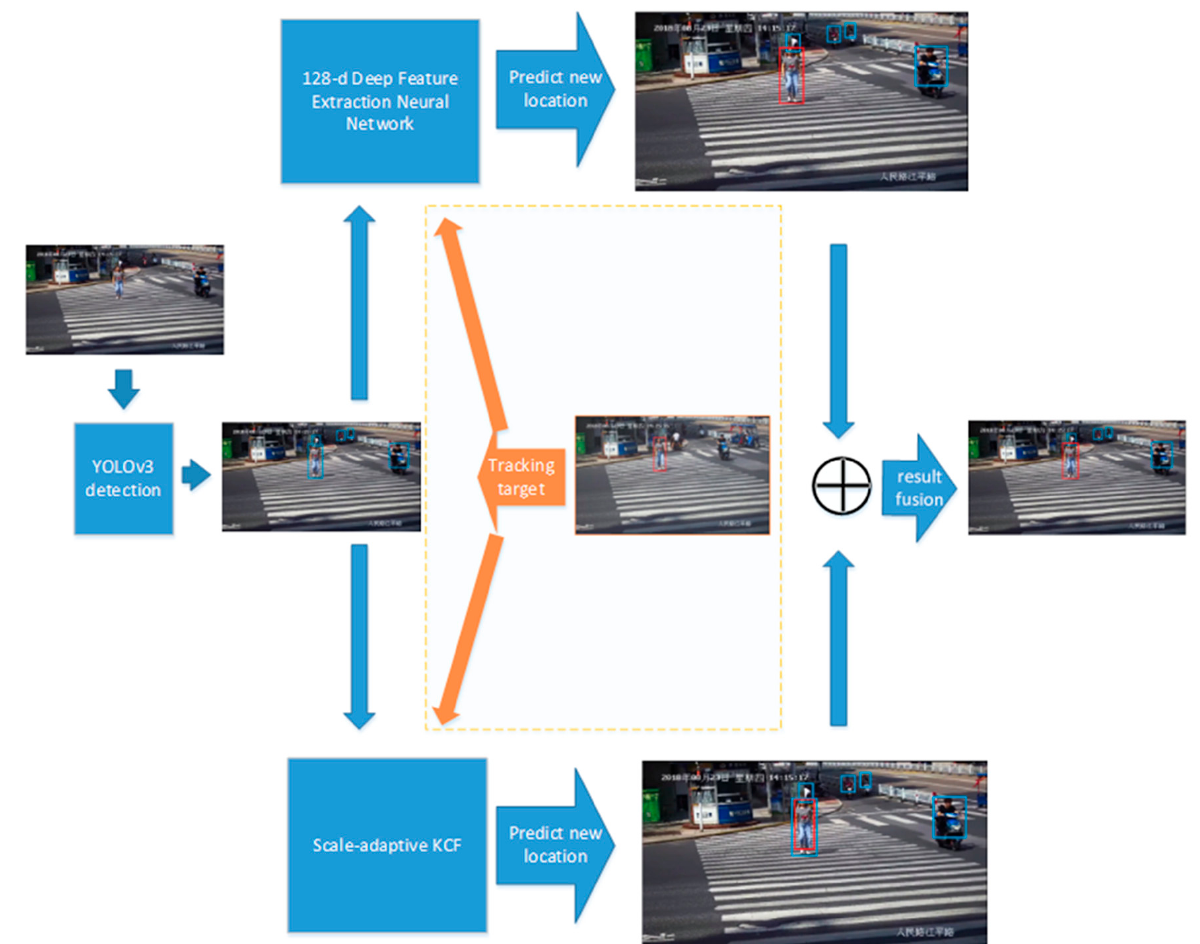
Figure 1. Schematic diagram of the scale-adaptive KCF (kernel correlation filter) mixed with the deep feature (SKCFMDF) algorithm. YOLOv3: you only look once version 3.